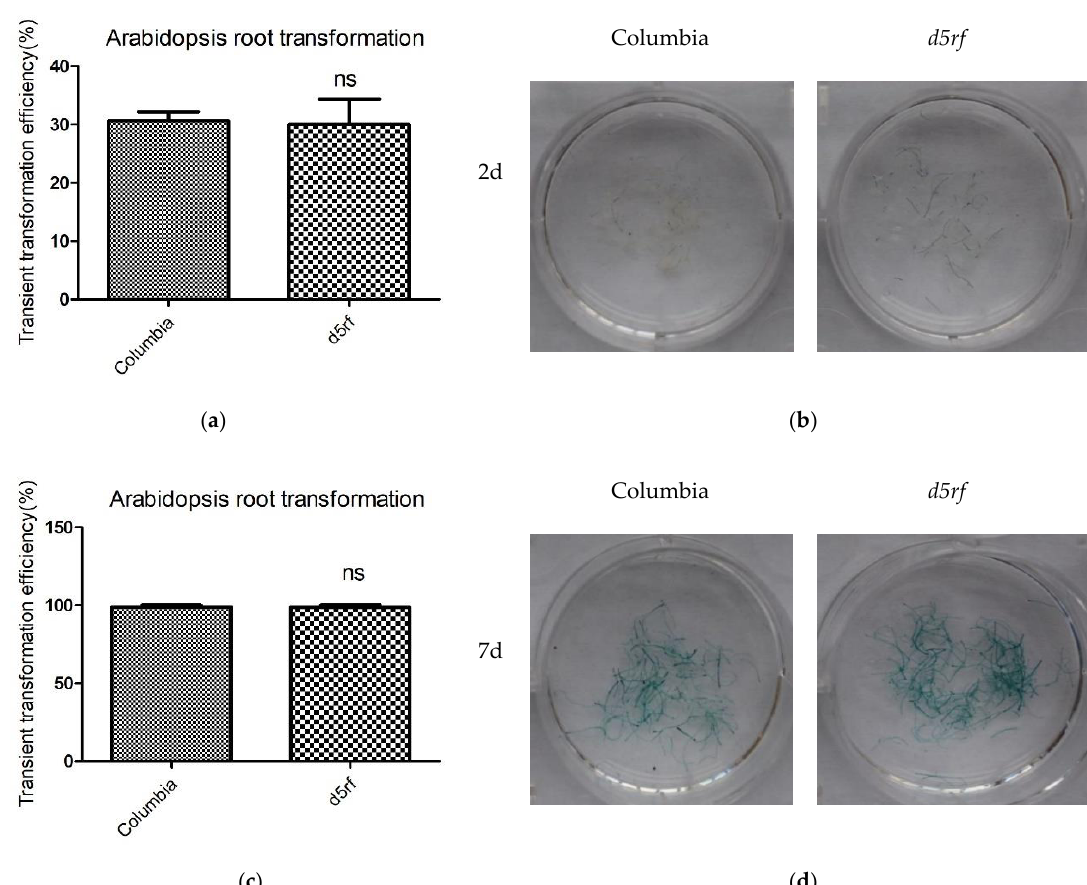
Figure 5. Transient transformation efficiencies of the wild-type and d5rf plants. Root segments of the wild-type and d5rf plants were inoculated with the A. tumefaciens strain EHA105 carrying the uidA gene within the T-DNA. Two ( a , b ) or seven days ( c , d ) later, the inoculated root segments were collected and stained with X-Gluc. The experiment was repeated three times. The transient transformation e ffi ciency was calculated as: no. of root segments stained in blue / no. of root segments infected. All of the data are means ± SD from three biological replicates. The data were made into graphs using GraphPad PRISM 5 software (La Jolla, CA, USA). ns, none